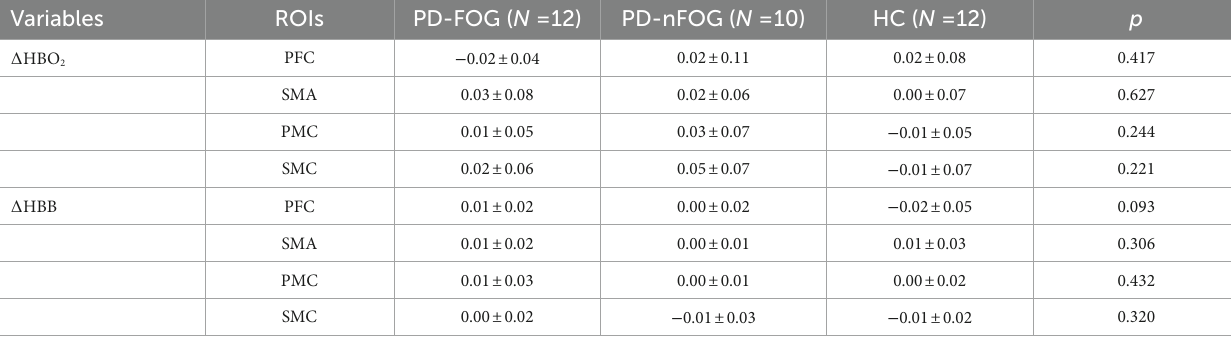
TABLE 2 One-way ANOVA results for haemodynamic responses of ROIs during the standing phase among the PD-FOG, PD-nFOG, and HC groups. Variables